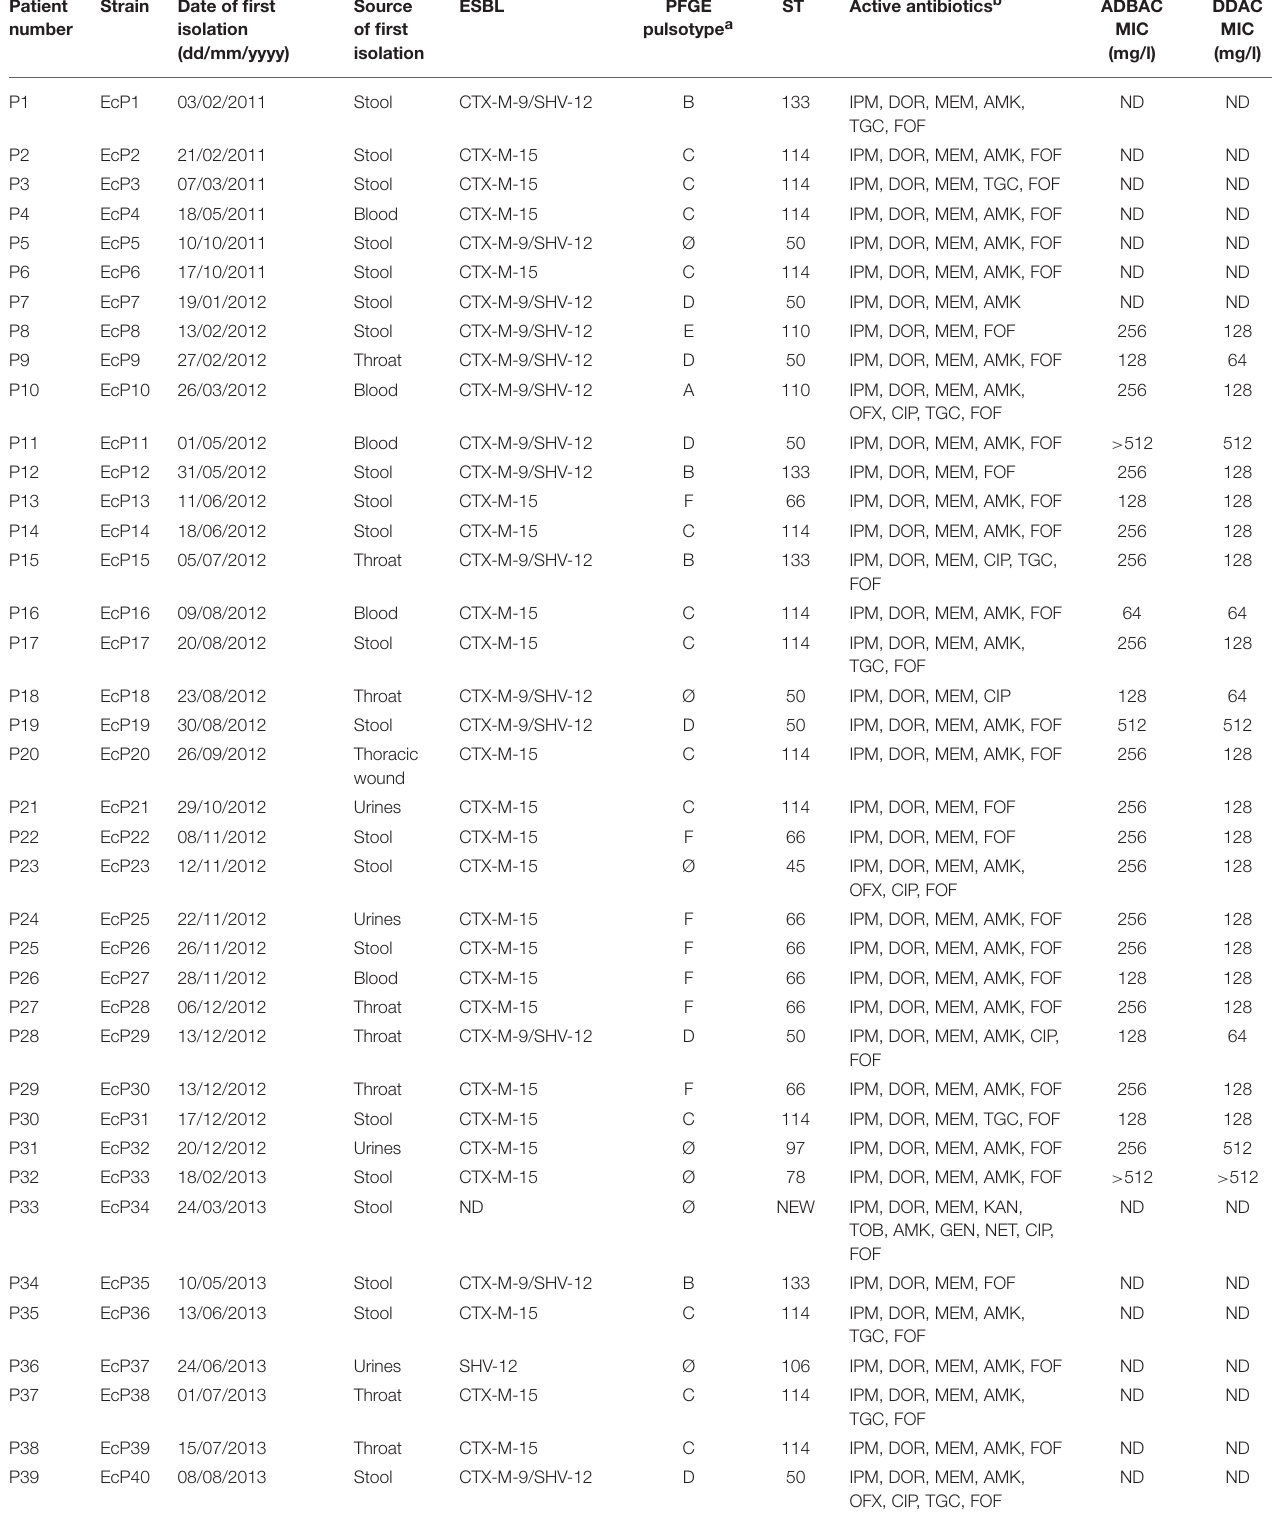
TABLE 1 | Characteristics of ESBL-producing Enterobacter cloacae isolated from patients hospitalized in the Hematology ward. Patient